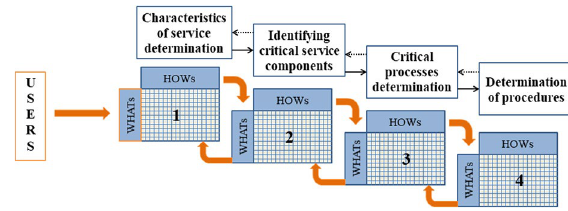
Figure 1. Stages of QFD method (method implementation on